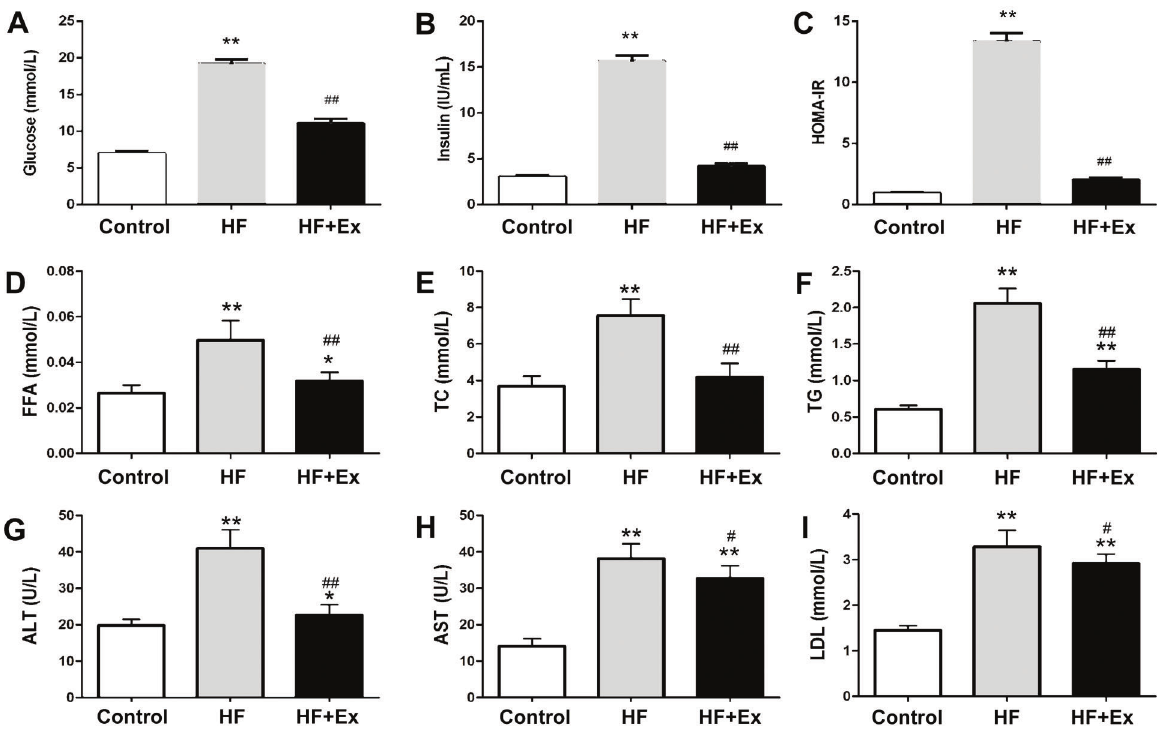
Figure 2. Effects of exenatide (Ex) on biochemical parameters of non-alcoholic fatty liver disease rabbits (n=8). At the end of the 8-week treatment, blood samples were collected for analysis of glucose ( A ), insulin ( B ), homeostasis model of assessment of insulin resistance (HOMA-IR) ( C ), free fatty acid (FFA) ( D ), total cholesterol (TC) ( E ), triglyceride (TG) ( F ), alanine aminotransferase (ALT) ( G ), aspartate aminotransferase (AST) ( H ), and low-density lipoprotein (LDL) ( I ) levels after overnight starvation. Data are reported as means ± SD. *P o 0.05, **P o 0.01 compared with the control group; # P o 0.05, ## P o 0.01 compared with the high fat (HF) group